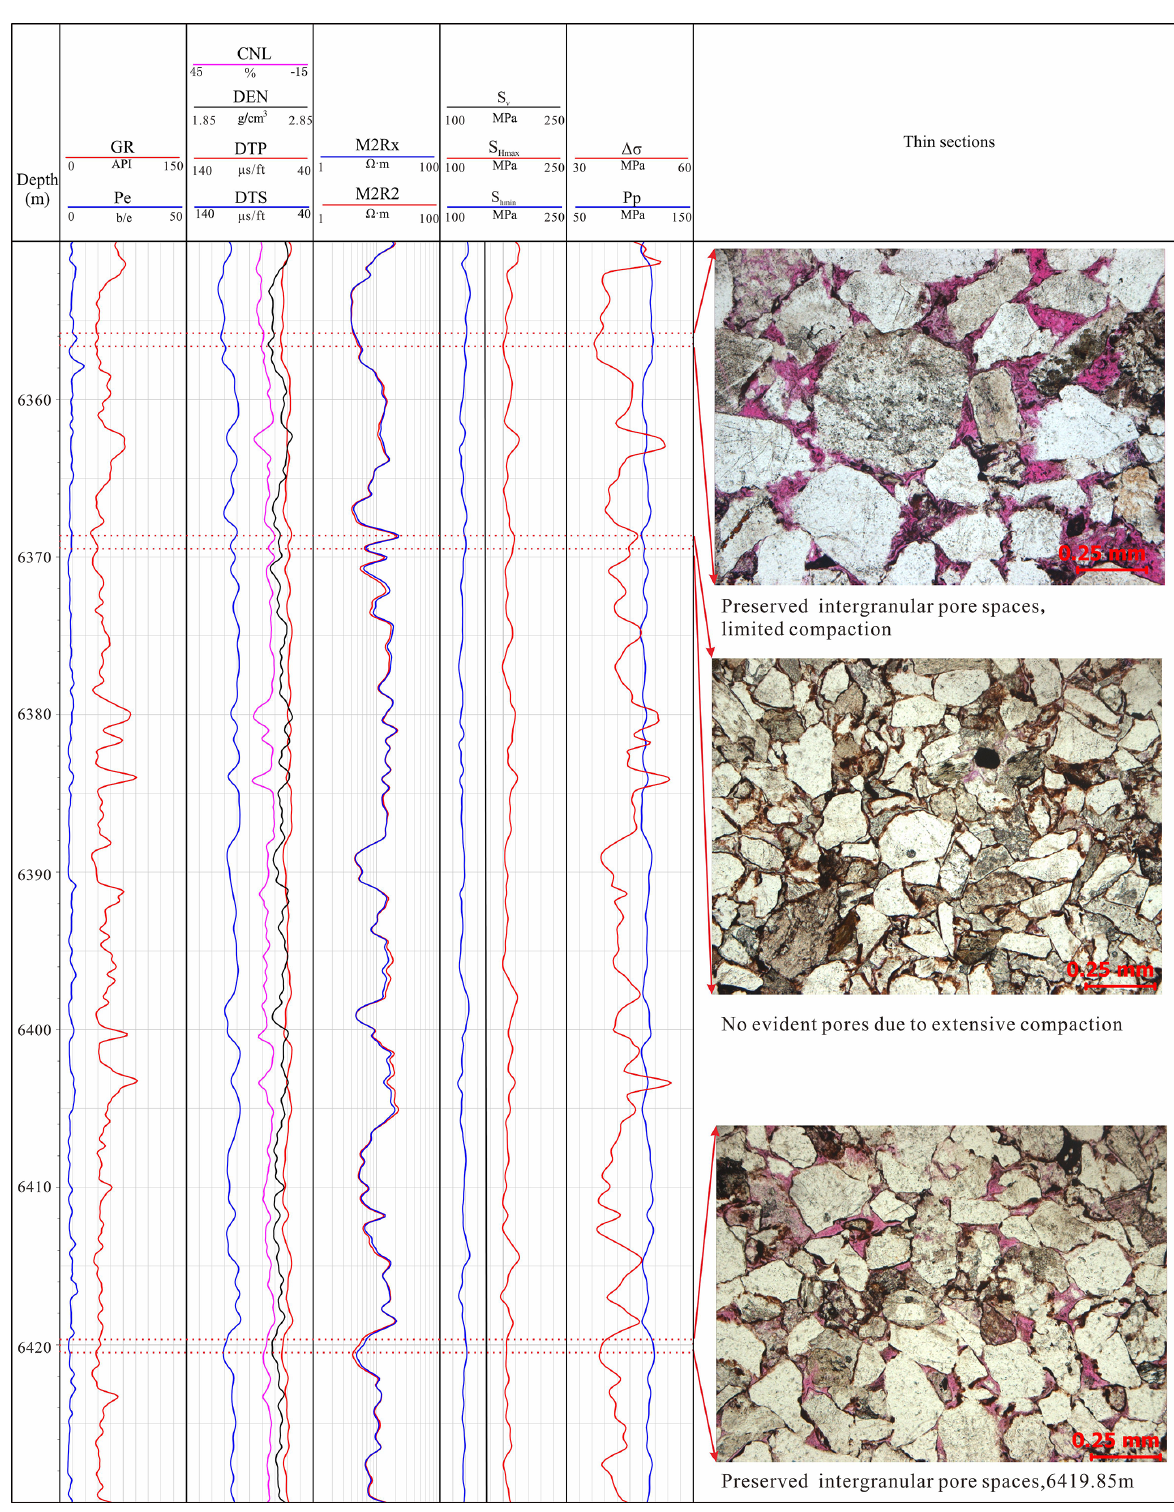
Figure 15. In situ stress magnitude determination via well logs and related thin sections in Well X501.